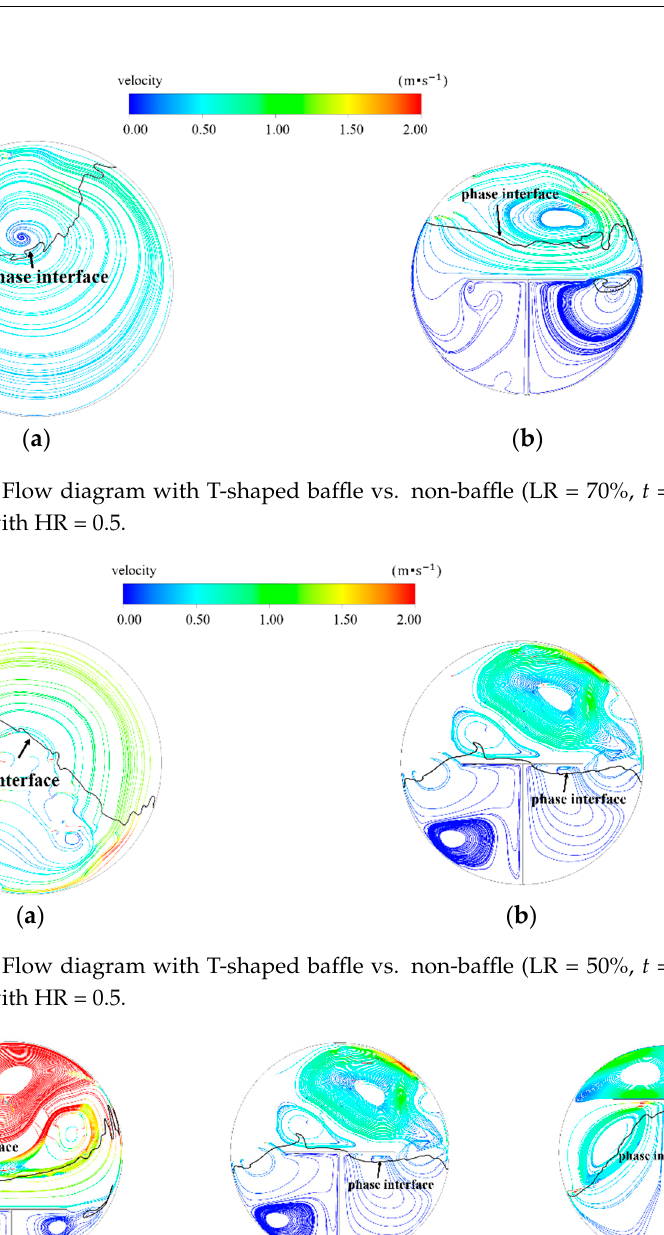
Figure 17. Flow diagram of liquid velocity with T-shaped baffle (LR = 50%, t = 1 s). ( a ) baffle with HR = 0.25; ( b ) baffle with HR = 0.5; ( c ) baffle with HR = 0.75.